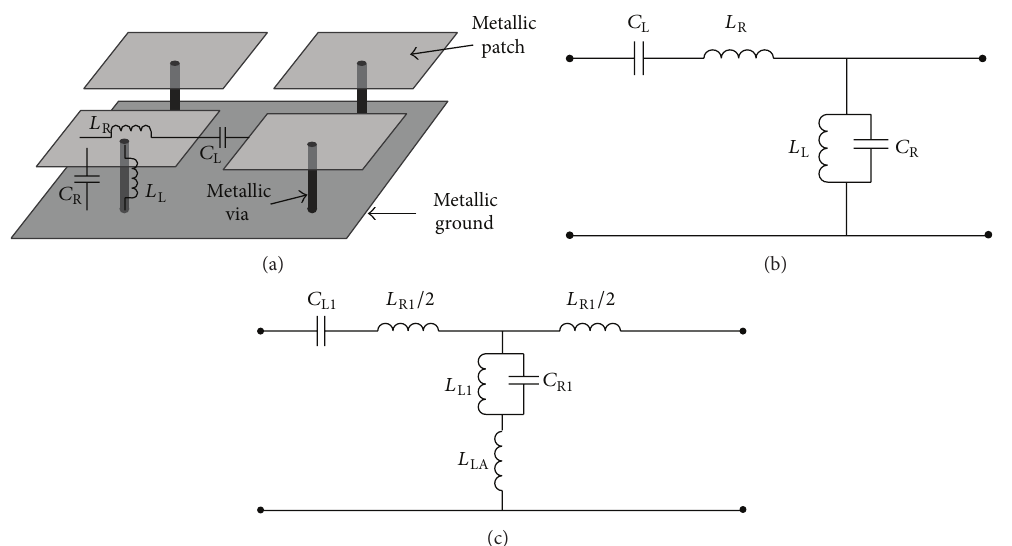
Figure 1: CRLH transmission line: (a) mushroom-like EBG model, (b) equivalent circuit of unit cell, and (c) equivalent circuit of proposed metamaterial